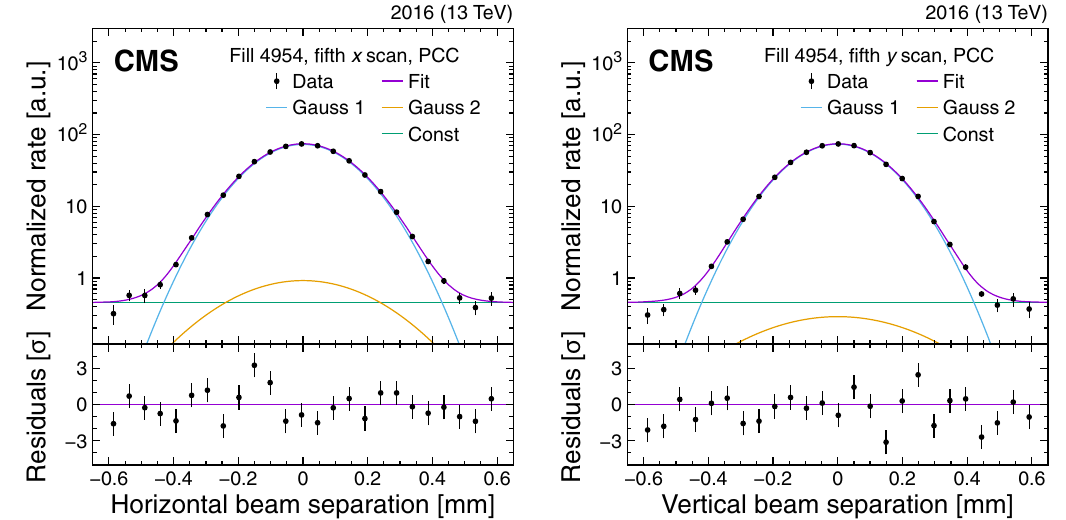
low, and green curves show the first and second Gaussian components and the constant component, respectively. All corrections described in Sect. 4.3 are applied. The lower panels display the difference between the measured and fitted values divided by the statistical uncertainty